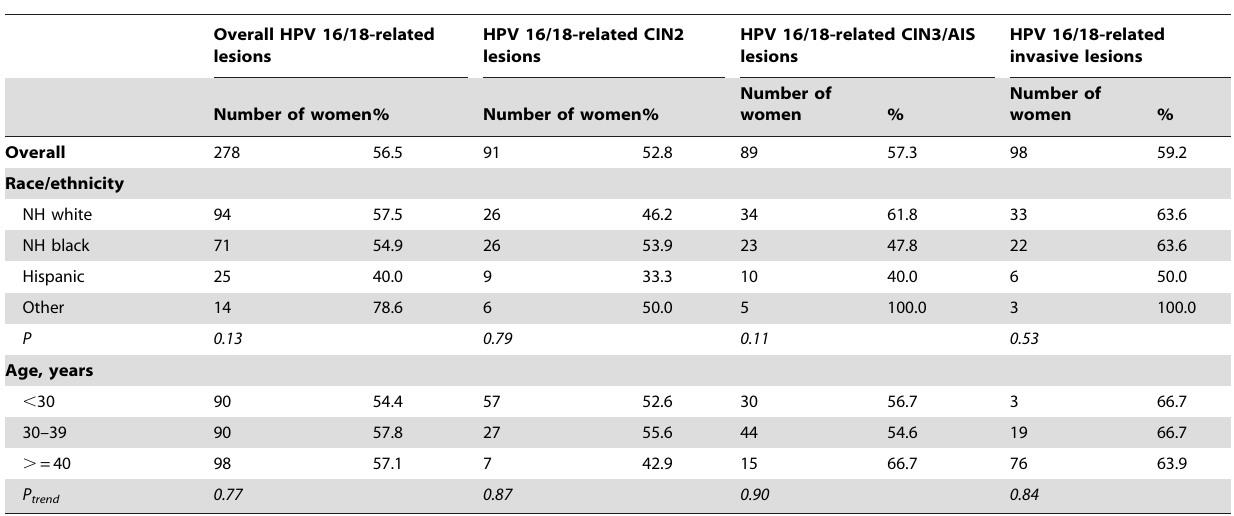
Table 4. HPV 16 and 18 type prevalence in cervical intraepithelial lesions, by diagnosis and